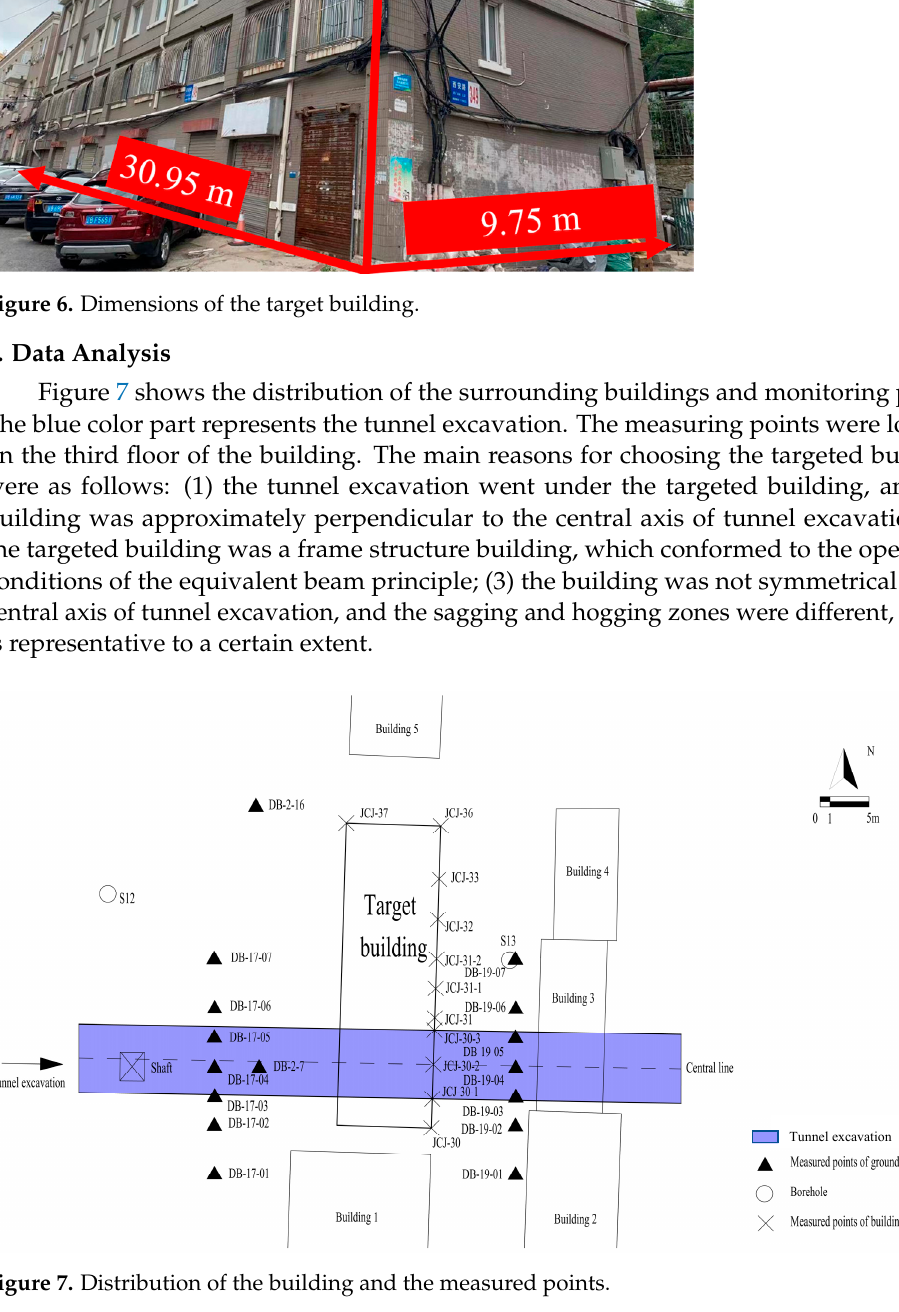
10 of 22 Figure 5. Geological pro fi le of the tunnel and location of the building .